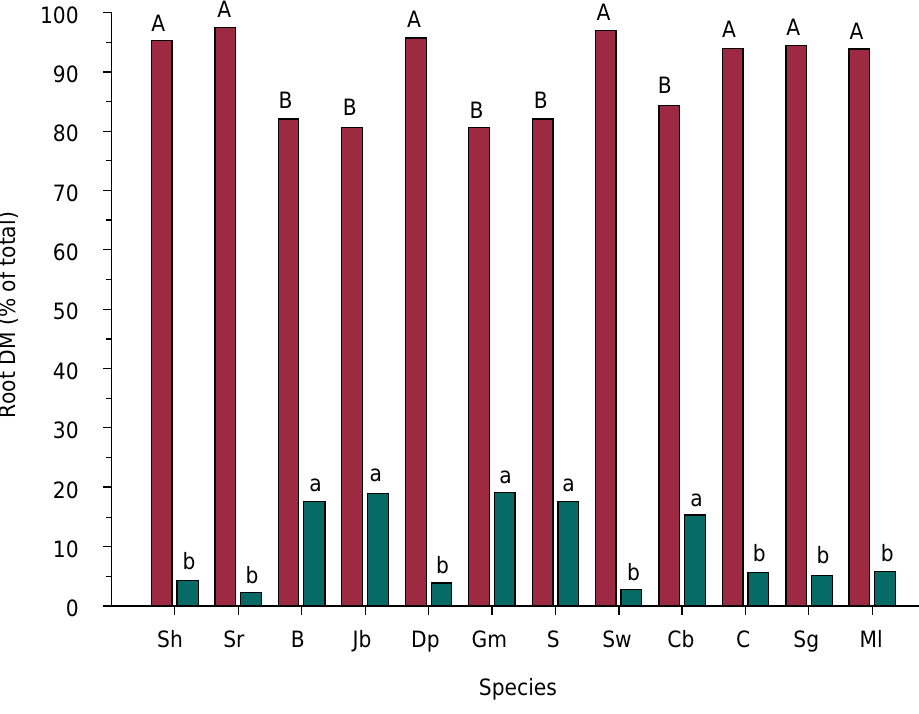
Figure 2. Relative horizontal distribution of root dry matter (DM) in the 0.00-0.10 m soil layer, either near the plant row (or seed hole) (red bars) or between rows (green bars), determined for crops grown in the spring/summer (% of total DM in the layer). Species: Sh = sunn hemp; Sr = showy rattlebox; B = dry edible bean; Jb = jack bean; Gm = gray mucuna; S = soybean; Sw = sunflower; Cb = castor bean; C = corn; Sg = sorghum; Ml = millet. Means followed by the same letters for plant row (uppercase) or between rows (lowercase) do not differ significantly by the LSD test